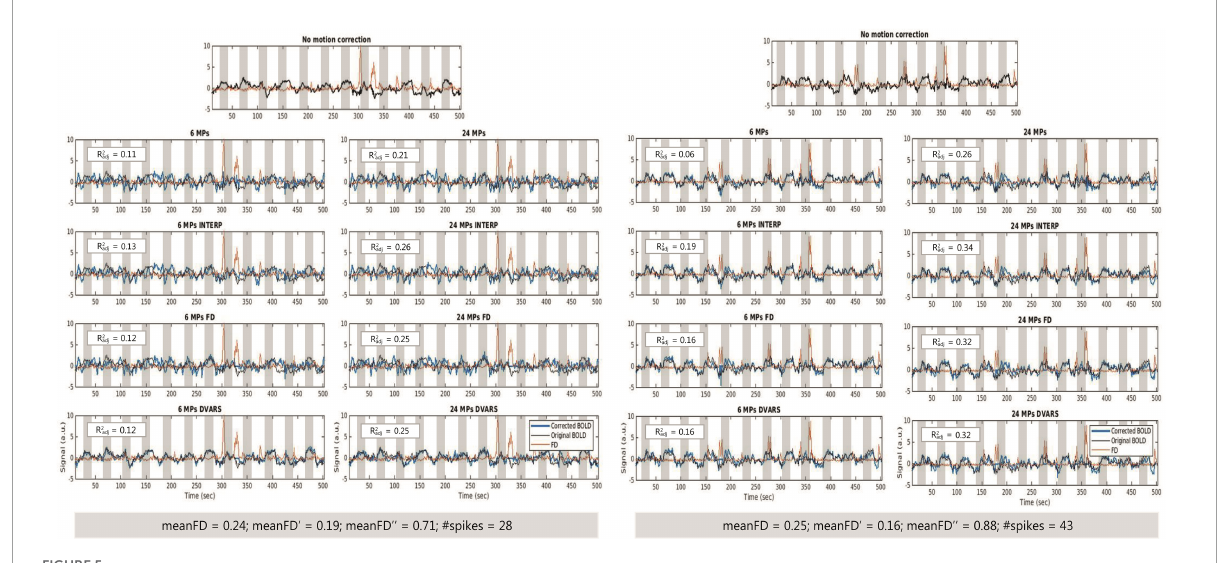
FIGURE5 (Left) Time courses of the BOLD signal, before motion correction and after motion correction with each approach, and mean FD for one participant from the HC group. (Right) Time courses of the BOLD signal, before motion correction and after motion correction with each approach, and mean FD for one participant from the MS group. Measurements of FD allow the identification of spikes in the data, e.g., close to 300 s (HC participant) and 350 s (MS